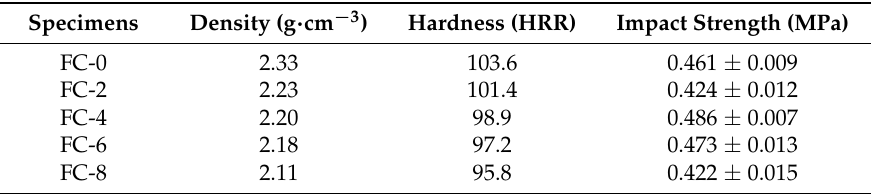
Table 2. Physio-mechanical properties of the friction specimens.